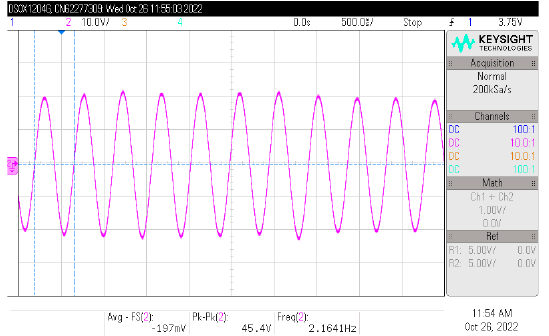
Figure 11. Waveform of structural vibration displacement under the wind speed of 2.5 m/s. As is shown in Figure 12, we conducted experiments in order to verify the proposed hybrid energy harvesting approach. The red curves in the figure show the vibration displacement, and the blue curves show the voltage of the piezoelectric element. The set of waveform data was deduced from an oscilloscope, and then it was replotted using MATLAB software. When it is in the suppress-vibration functional state, because the piezoelectric element is injected with electricity, the voltage is relatively high, and the amplitude waveform of displacement is nearly zero, so the structural vibration amplitude is suppressed to zero. When it is in the fill-vacancy functional state, the electric energy of the piezoelectric element is harvested to subsequent circuits due to the positive piezoelectric effect, the voltage waveform is relatively small, and the displacement waveform shows that the structure is in an oscillating state. Please note that in Figure 12a, the piezoelectric voltage waveform and simulation results are inconsistent. This is because, when the actual piezoelectric element is placed in the interface control circuit, a current drain phenomenon will occur. It is obvious when the voltage is relatively high.